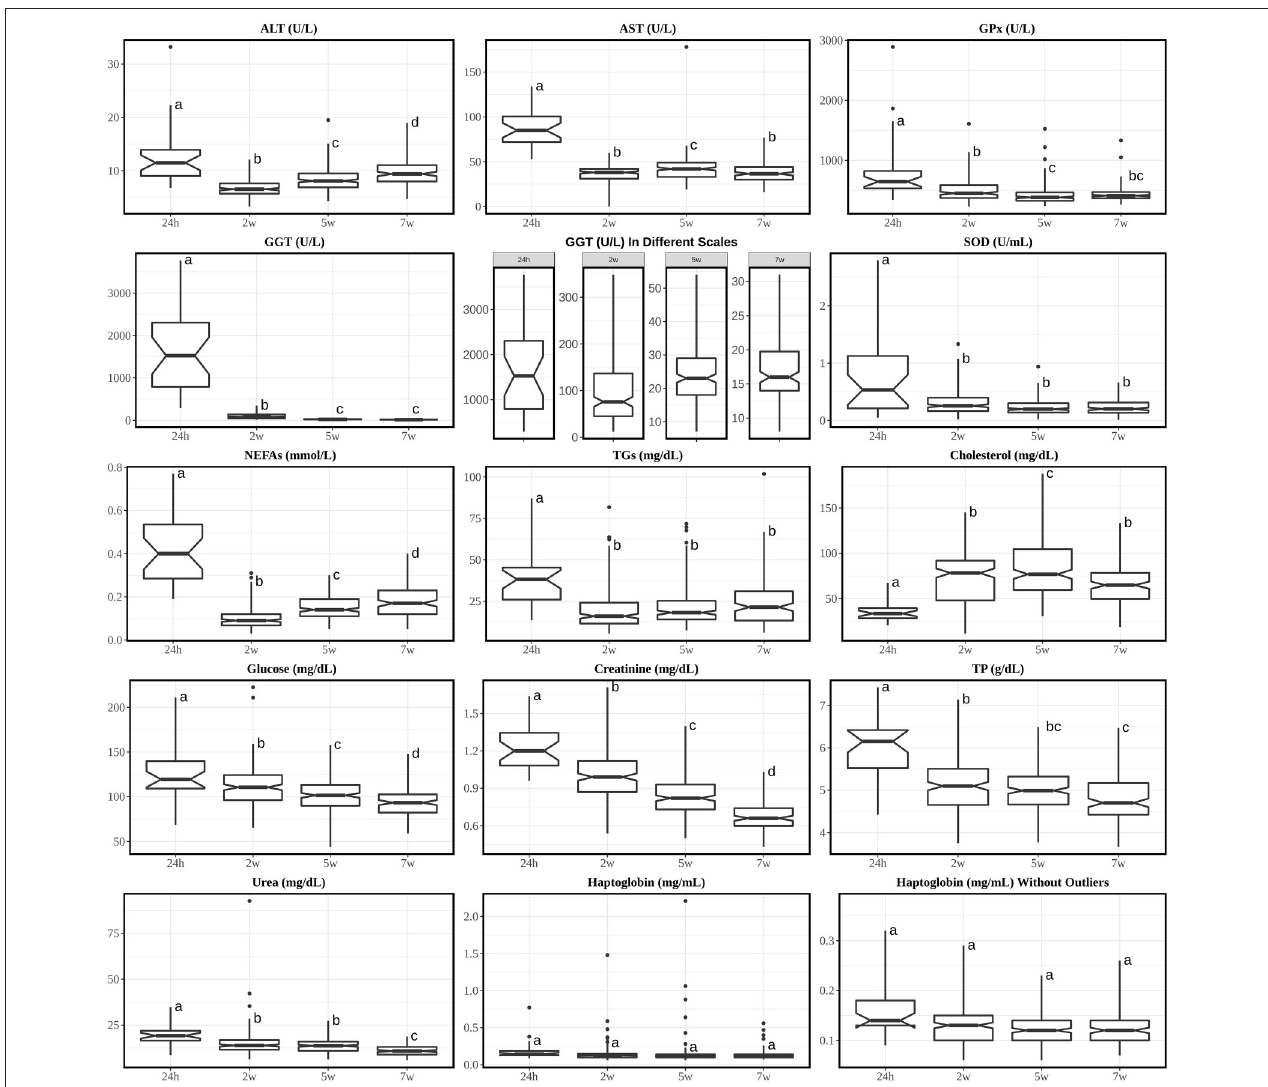
FIGURE 1 | Boxplots of analytes with Tukey’s HSD posthoc with Bonferroni correction from calves’ sera at 24h, 2w, 5w, and 7w of age. Annotations over the boxes with different superscripts are significantly different ( p < 0.05). Interquartile fence was set between Q1-3*IQR and Q3 + 3*IQR. 24h, calves at 24 hours of age; 2 w, calves at 2 weeks of age; 5 w, calves at 5 weeks of age; 7 w, calves at 7 weeks of age. Analytes were alphabetically plotted according to the orders of